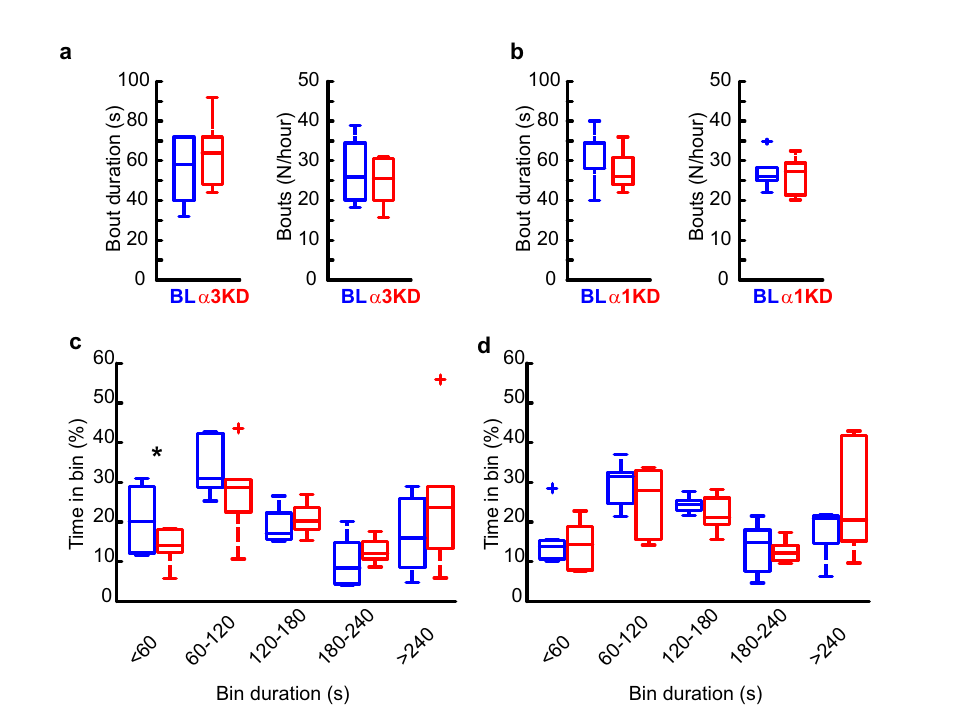
Fig. 2 α 3KD, but not α 1KD, in PV + TRN neurons decreased time spent in the shortest (<60 s) NREM bouts. a Compared with their baseline conditions (BL; blue), α 3KD (red) mice ( n = 6) did not have altered durations or number of NREM bouts. b α 1KD mice ( n = 7) also did not have altered durations or number of NREM bouts. c The proportion of time spent in short bouts lasting <60 s was signi fi cantly reduced in α 3KD mice (two-tailed paired t -test, * p = 0.03), but no other bins showed any differences between BL and α 3KD ( n = 6). d The proportion of time spend in bouts was unchanged in α 1KD mice ( n = 7). Box plots: center lines represent median values, 75 th percentiles are box tops and 25 th percentiles are box bottoms. + symbols represent outliers de fi ned as >1.5x the interquartile range away from box tops or bottoms. Data from whole 12 h light